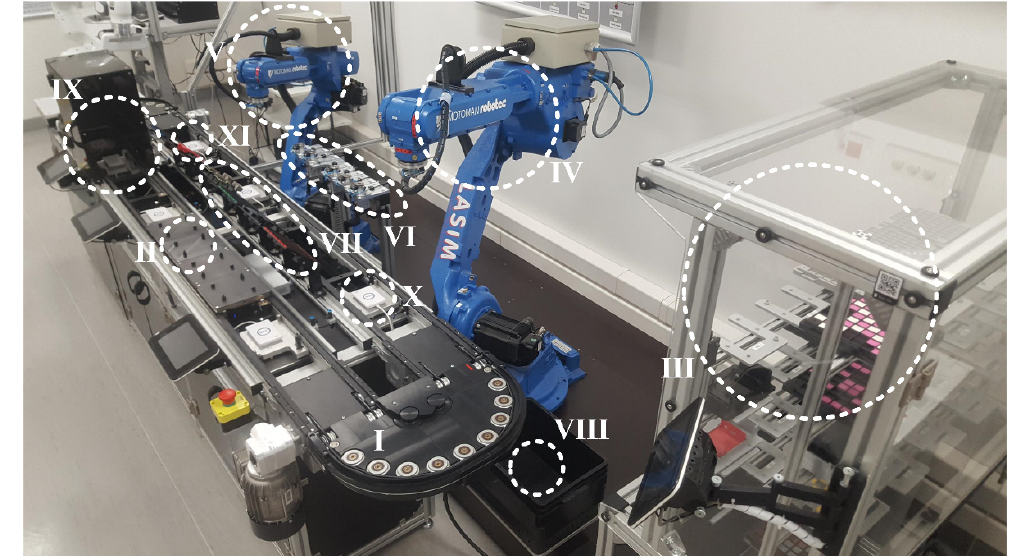
Figure 10. The Demo Center Smart Factory. Table 1. 12 products assembled in 4 successive scenarios with different tile color and quantity.